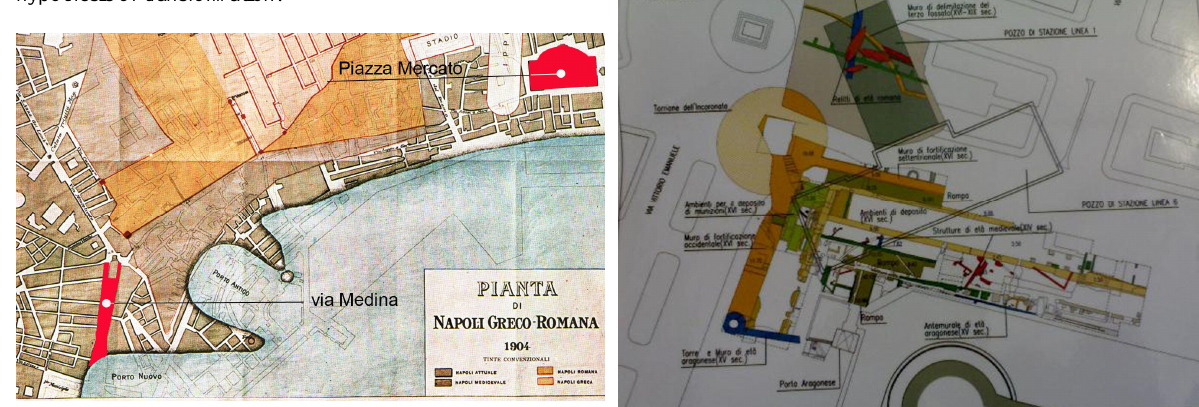
Figure 2: reconstruction by B. Capasso: Naples in Greek-roman period